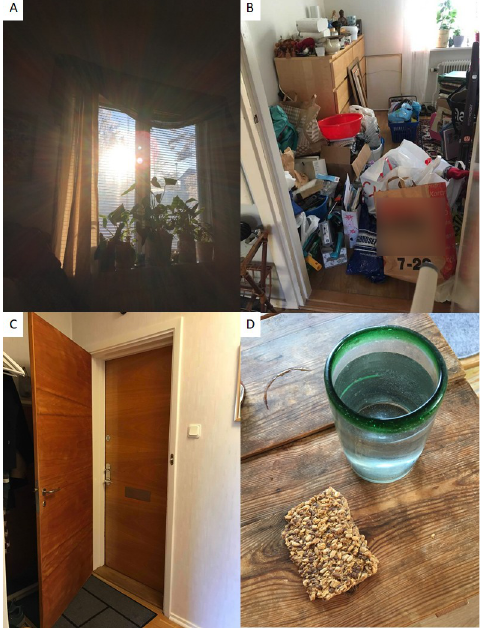
“When my headache is severe I cannot cook proper